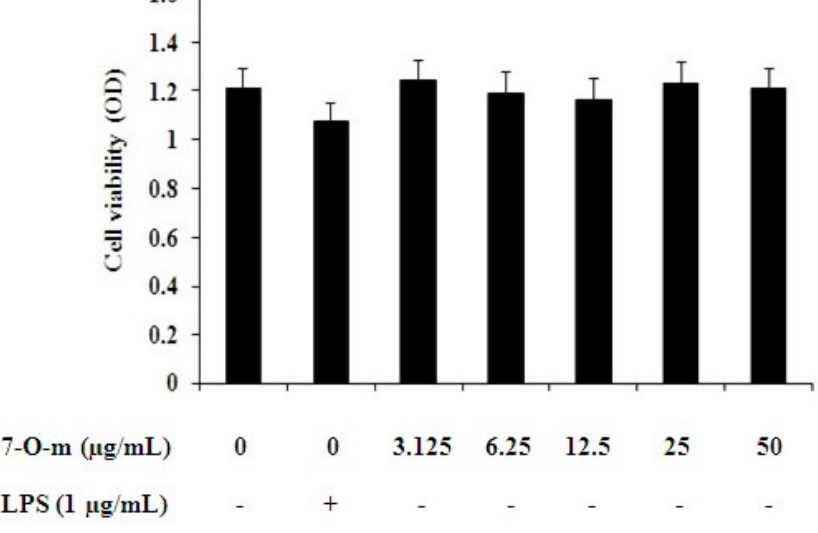
Figure 2. Effects of 7- O -methylnaringenin on the viability of RAW 264.7 cells. RAW 264.7 cells were incubated in the presence or absence of 7- O -methylnaringenin (0 to 50 µ g/mL) for 24 h. Cell viability was determined by the MTT assay. Data are presented as means ± SEM of three independent